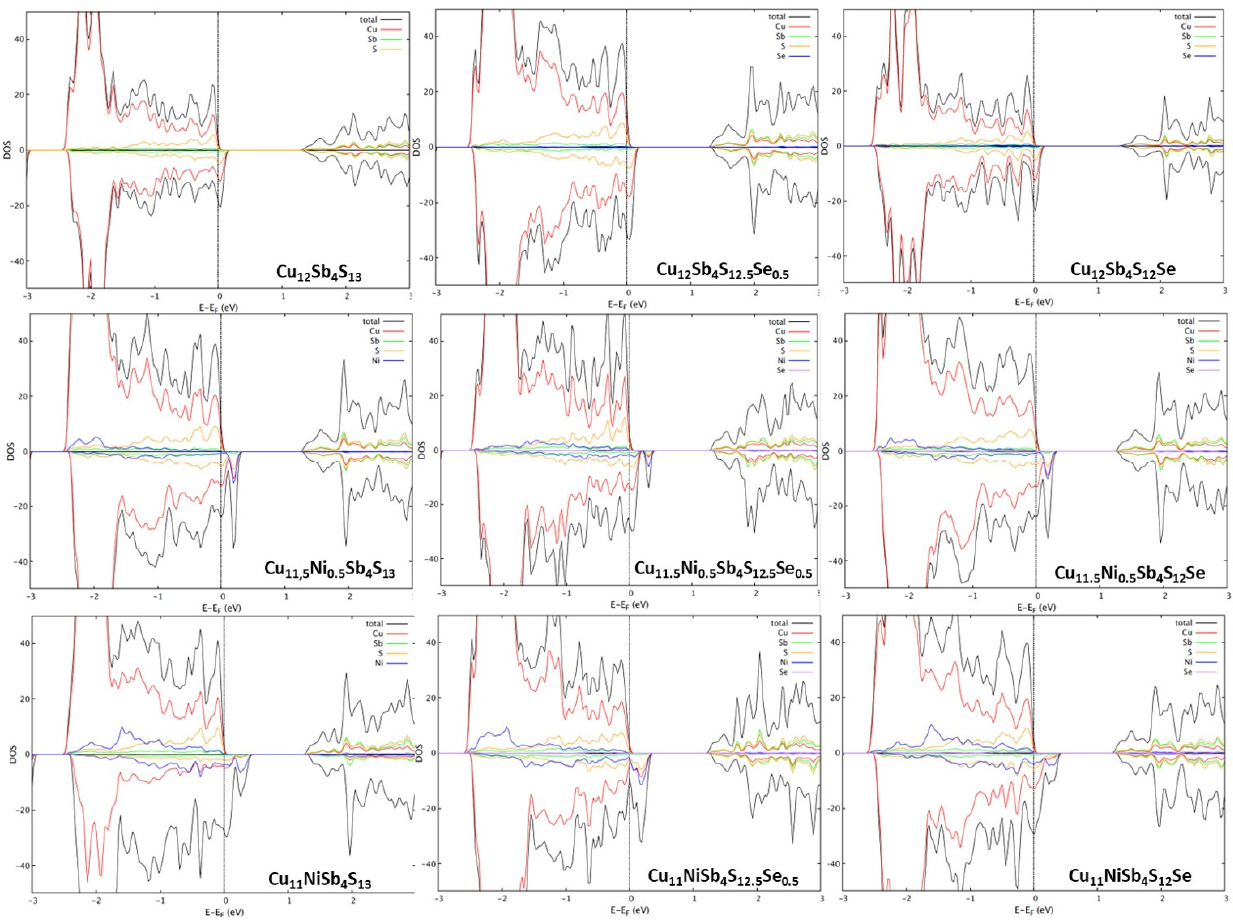
Figure 2. Density of states calculated through the WIEN2k package for tetrahedrite with specific stoichiometric content of Ni and Se, in accordance with the formula Cu 12 − x Ni x Sb 4 S 13 − y Se y (0 ≤ x ≤ 1.0; 0 ≤ y ≤ 1.0).